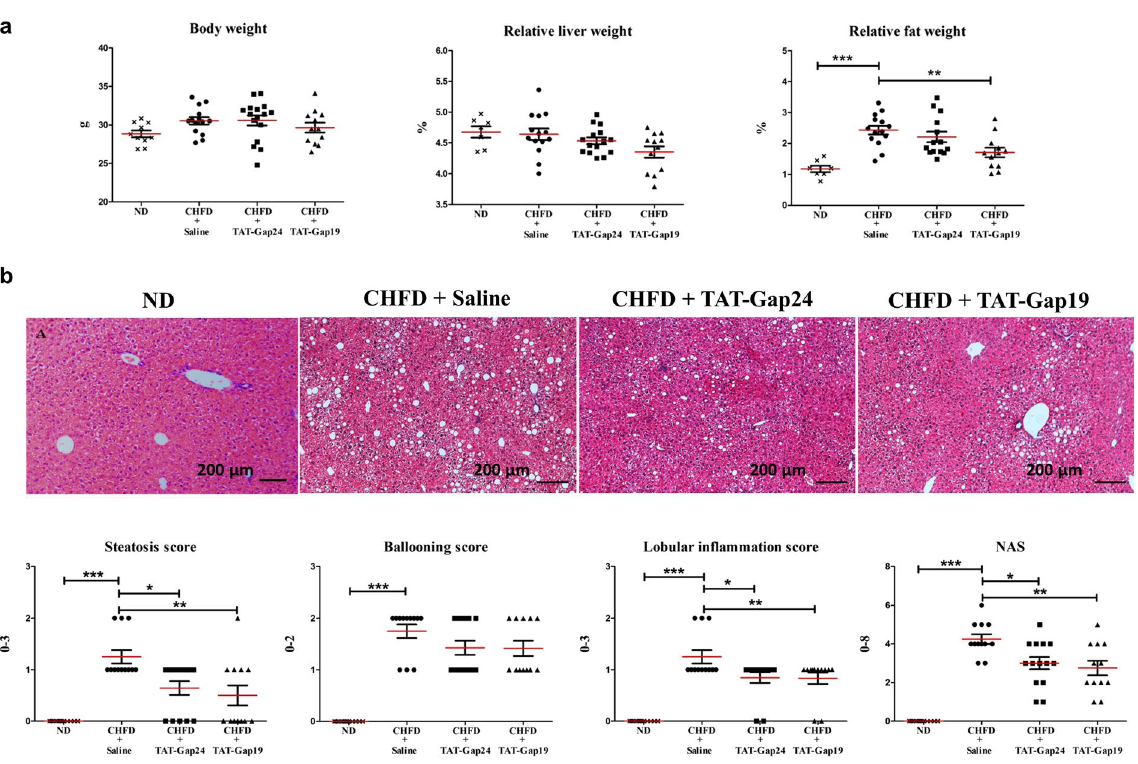
Figure 3. Effects of TAT-Gap24 and TAT-Gap19 on biometric parameters and liver histology in NASH. After 8 weeks of CHFD, an osmotic pump was surgically implanted in the abdominal cavity, which ensured sustained release of 1 mg/kg/day TAT-Gap24 (n = 11) or TAT-Gap19 (n = 12) or saline (n = 14) for another 2 weeks while continuing the diet. ( a ) Body, fat and liver of mice and relative liver and fat weight. ( b ) Steatosis, lobular inflammation, ballooning and NAS score based on hematoxylin-eosin staining of liver tissue of ND group (first panel), saline group (second panel), TAT-Gap24 (third panel) and TAT-Gap19 group (fourth panel). Data are expressed as means ± SEM with * p < 0.5, ** p < 0.01 and *** p <